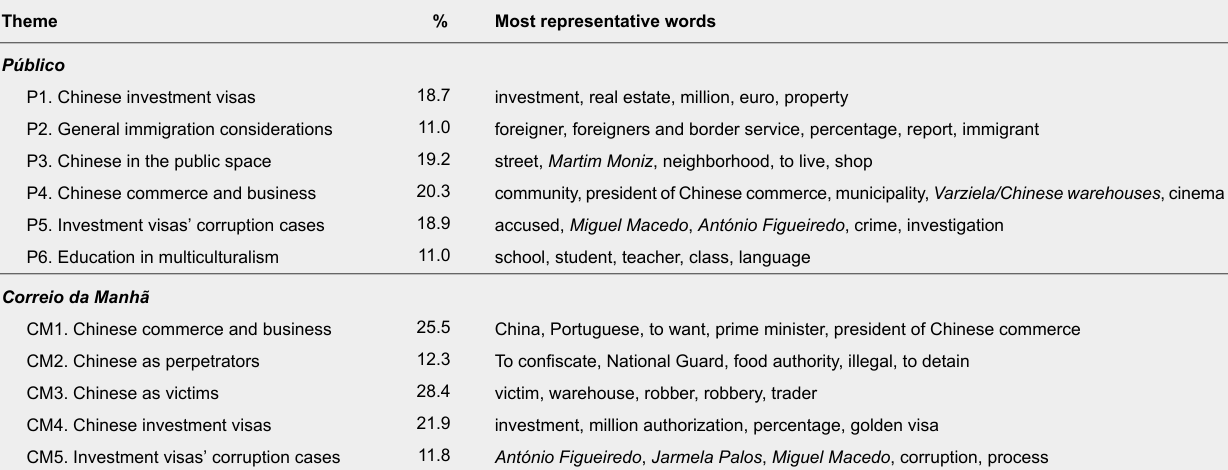
Most representative words%Theme